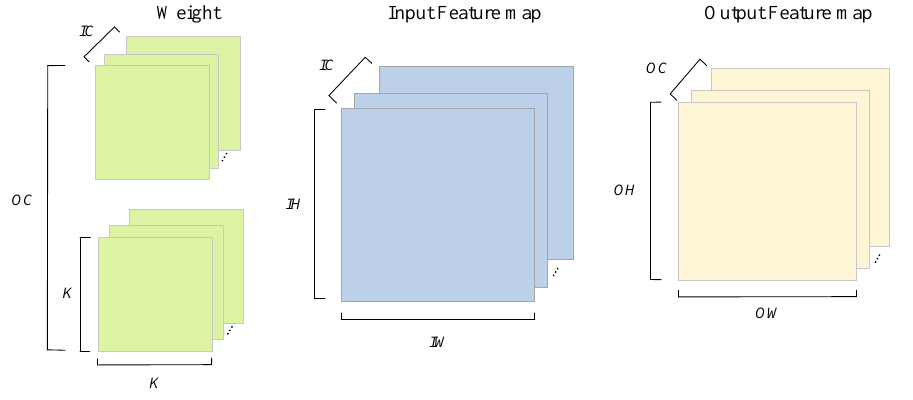
Figure 10. Convolutional calculation.